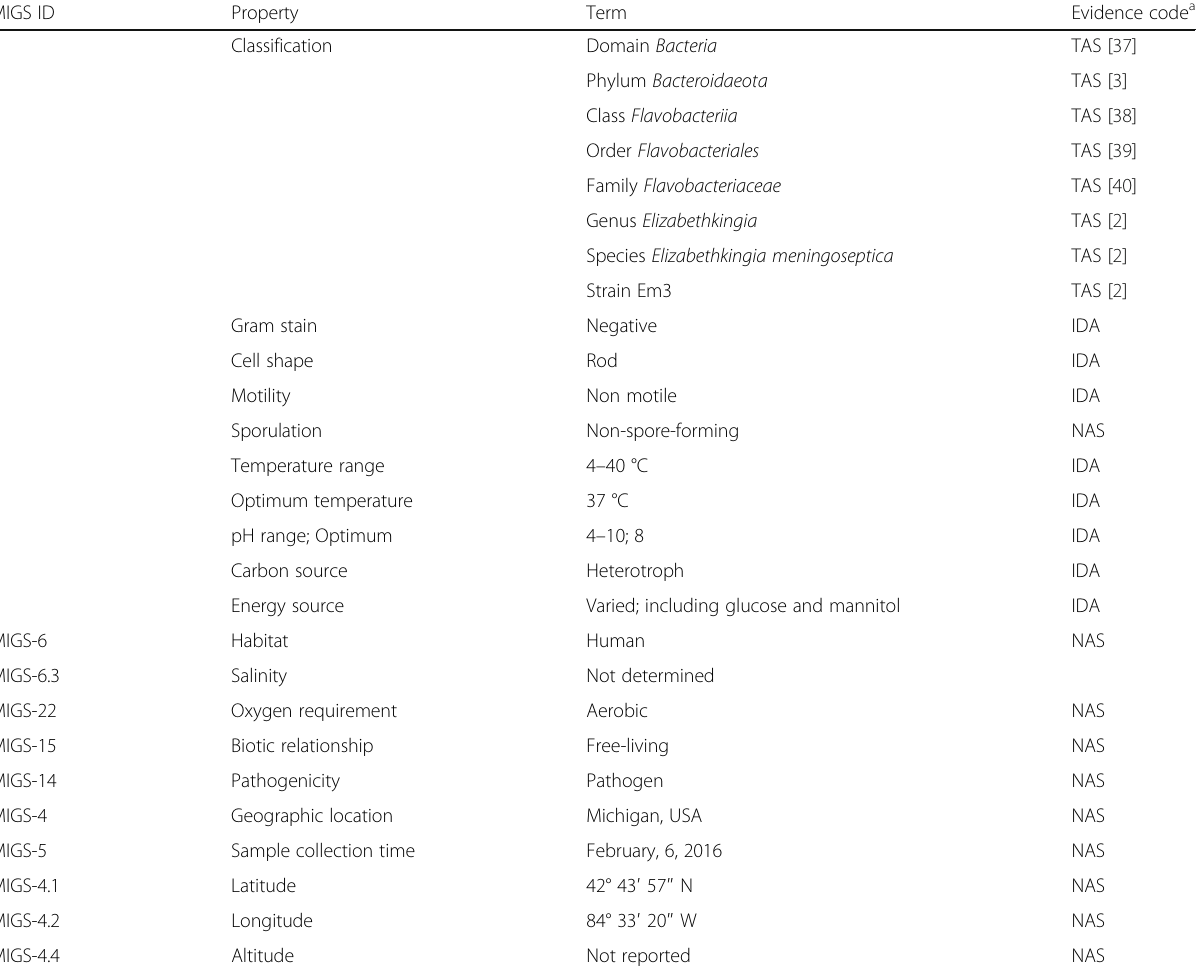
Table 1 Classification and general features of E. meningoseptica Em3 MIGS